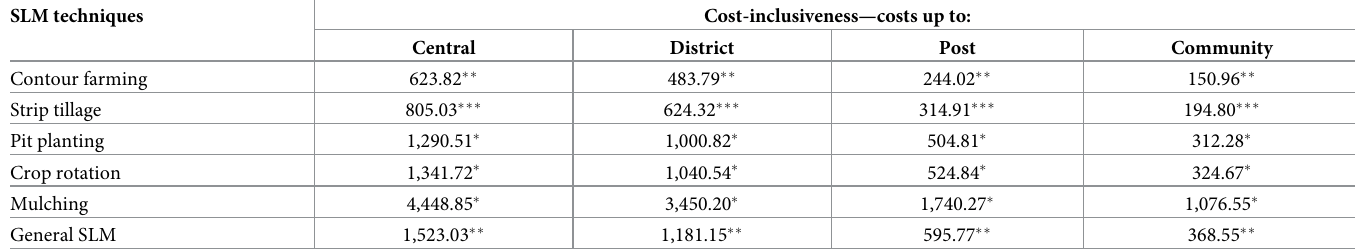
Table 6. CGAAS: Cost-effectiveness of the gendered treatment of the programme in increasing contact-farmers’ SLM knowledge. SLM